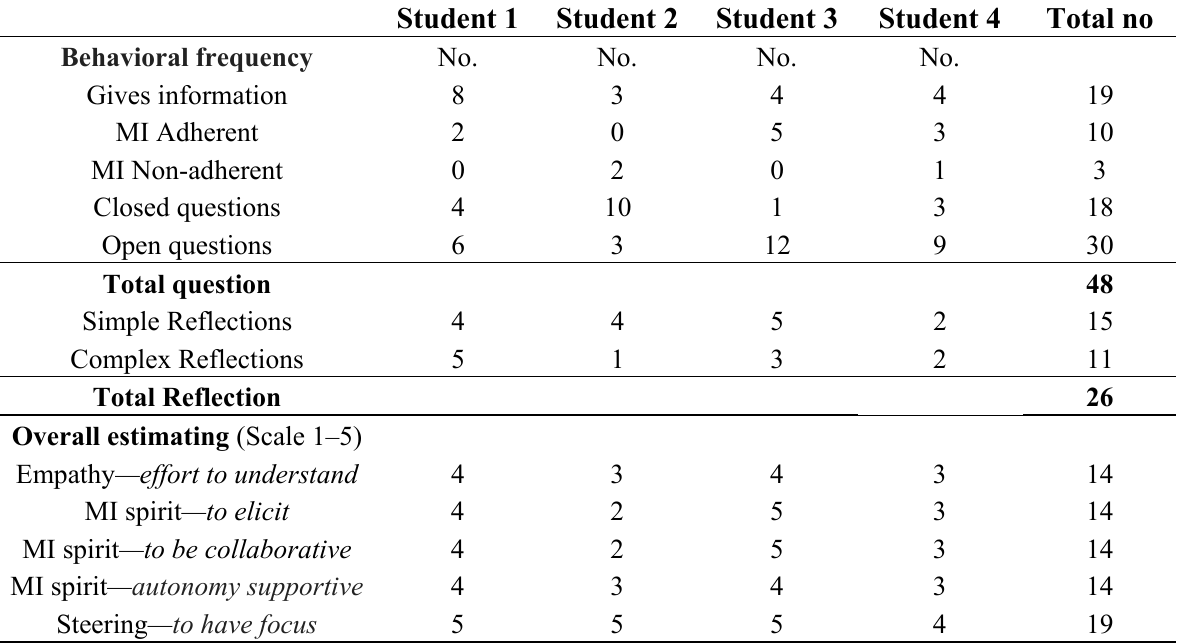
Table 1. Coding of the number of comments from “behavioral frequency” and observations from the “overall estimating” in motivational interviewing (MI) from the students in the intervention group, according to MITI